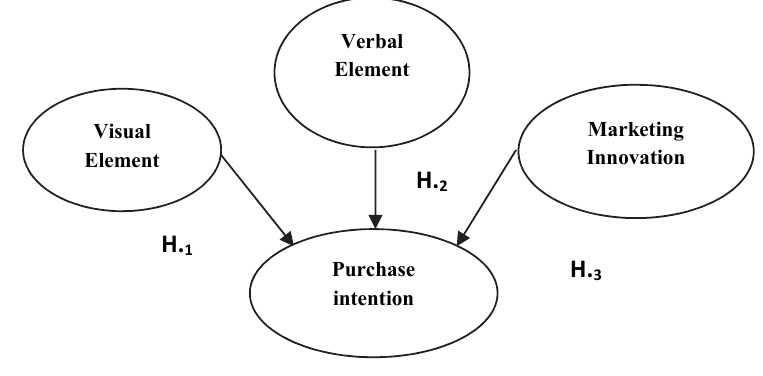
Fig. 1. The research model of